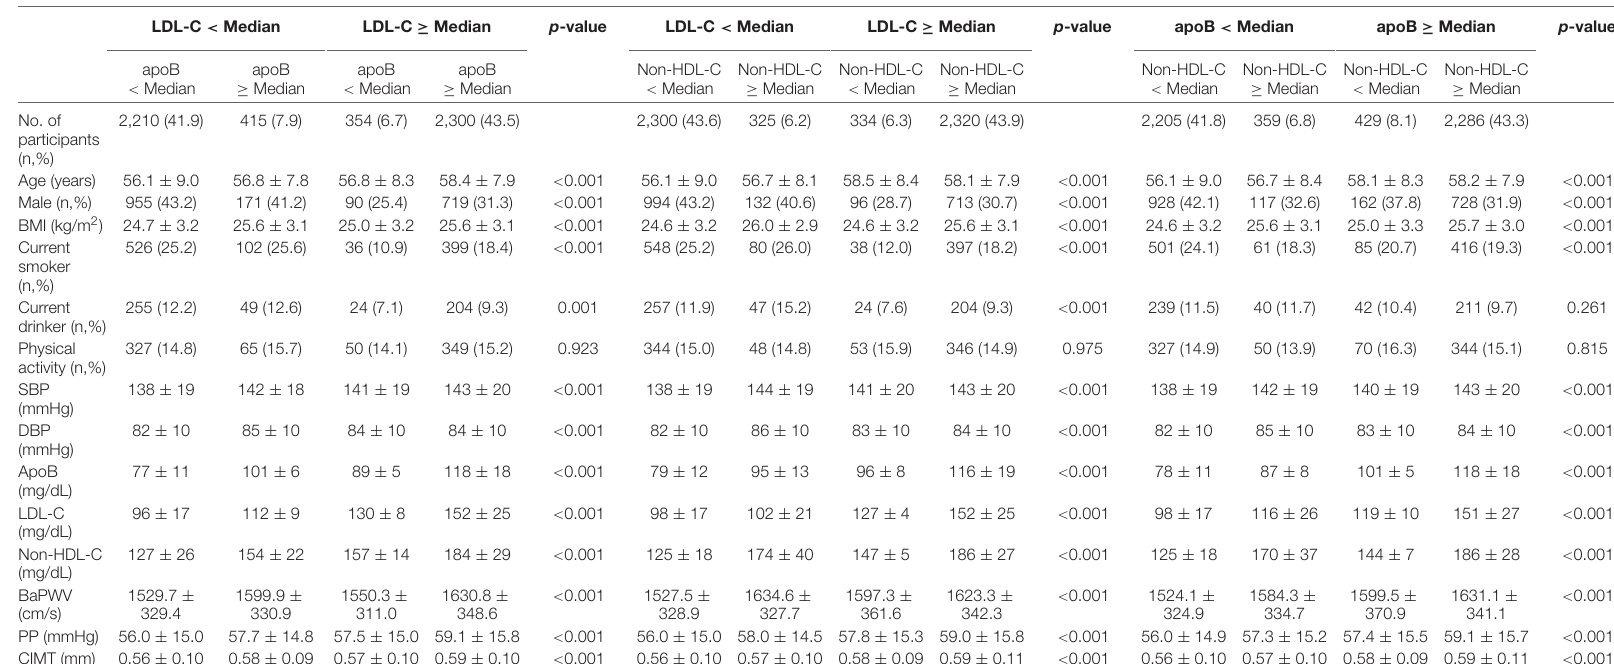
TABLE 1 | Baseline characteristics of participants with concordant and discordant values of apoB vs. LDL-C, non-HDL-C vs. LDL-C, and apoB vs. non-HDL-C ( n =